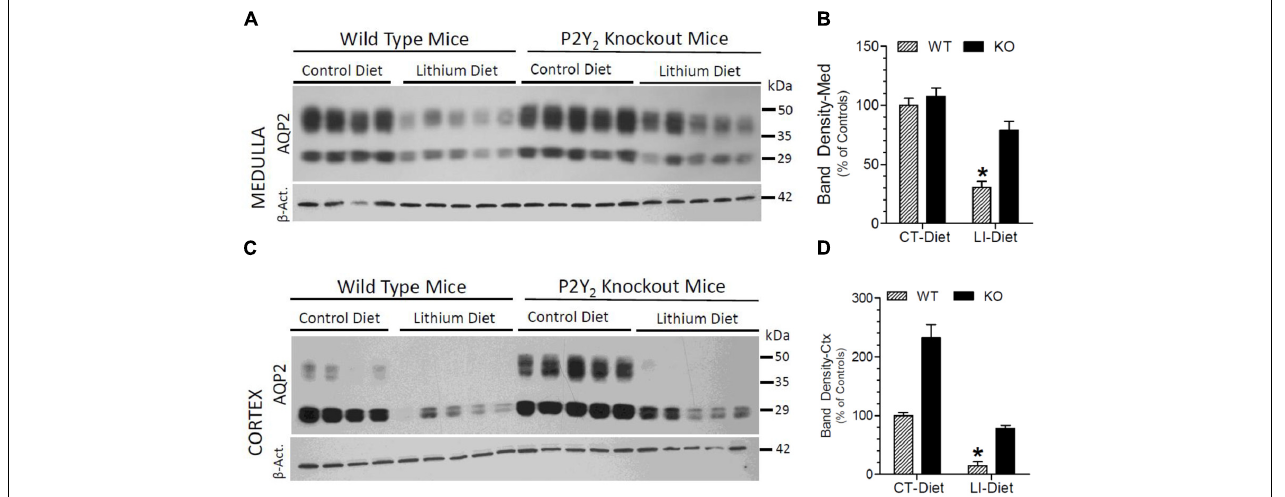
FIGURE 3 | Terminal (5 months) protein abundances of AQP2 in the kidney of mice fed control or lithium-added diet determined by Western blotting. (A) Immunoblot profile of AQP2 and β -actin protein bands in the renal medulla of different groups of mice. (B) Mean densitometric values of normalized AQP2 and β -actin protein bands in the medulla expressed as percent of mean values in the control diet fed WT mice. (C) Immunoblot profile of AQP2 and β -actin protein bands in the renal cortex of different groups of mice. (D) Mean densitometric values of normalized AQP2 and β -actin protein bands in the cortex expressed as percent of mean values in the control diet fed WT mice. ∗ Significantly different from the CT-Diet fed WT and LI-Diet fed KO mice by one-way ANOVA. For results of two-way ANOVA, refer to Table 1 . WT-CT, wild type mice on control diet; WT-LI, wild type mice fed lithium-added diet; KO-CT, knockout mice on control diet; KO-LI, knockout mice on lithium-added